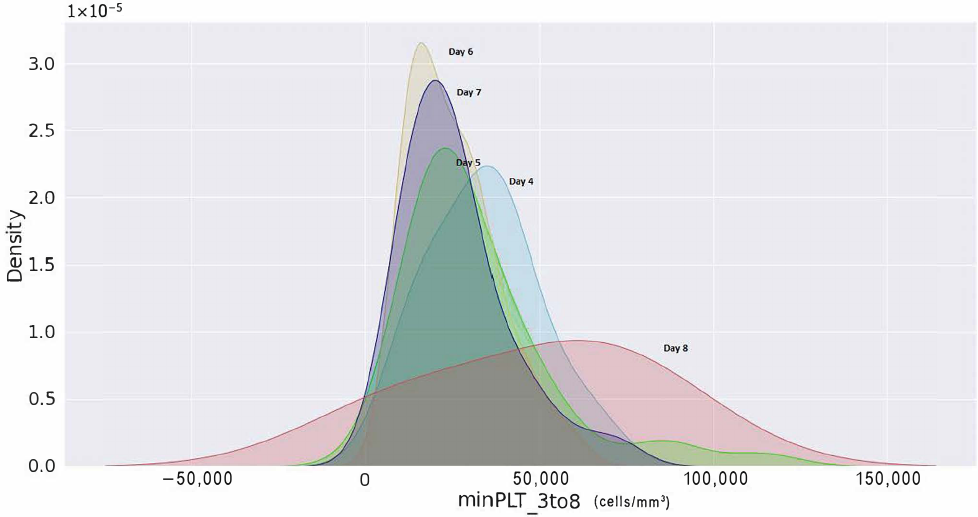
Figure 19. Minimum platelets count of shock victims as plotted each day since enrolment to the hospital using kernel density estimation plot.